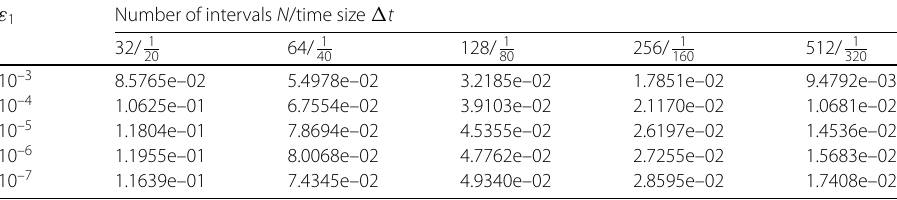
Table 8 Maximum error E N , M ε for Example 5.2 using the adaptive grid method with ε 2 = 10 –2